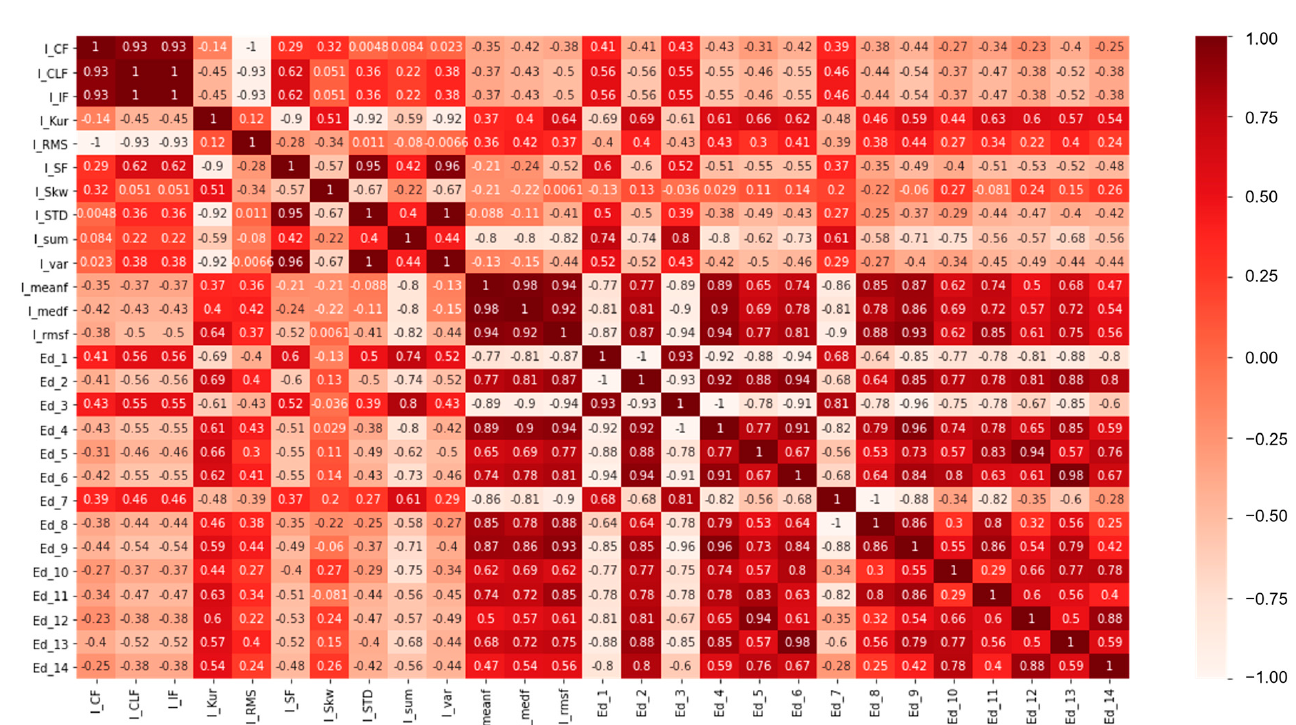
Figure 12. The correlation coefficients between all 27 features.